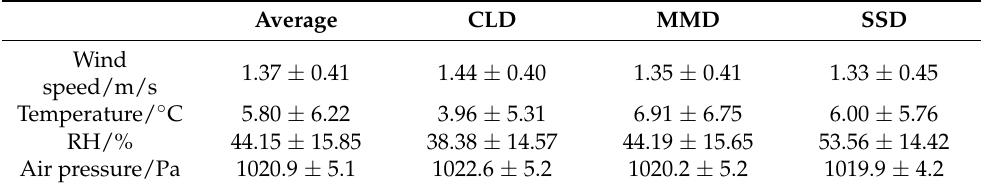
Figure 2. PM 2.5 mass concentration variation during the sampling period in Liaocheng. Table 1. Meteorological parameters and PM 2.5 concentrations at different pollution levels during the sampling period.